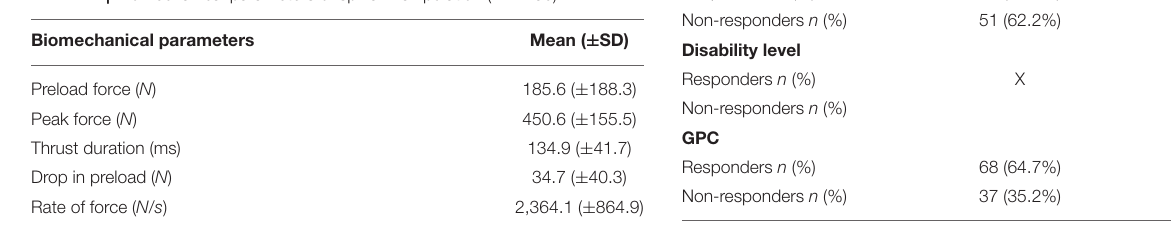
TABLE 2 | Biomechanical parameters of spinal manipulation ( n = 106).